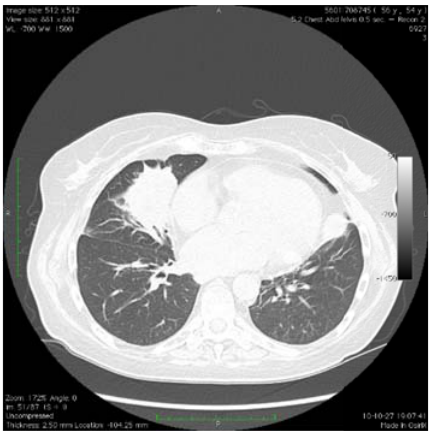
Figure2:CTofthechestshowstwometastaticfocusesinbothlungs and mediastinal